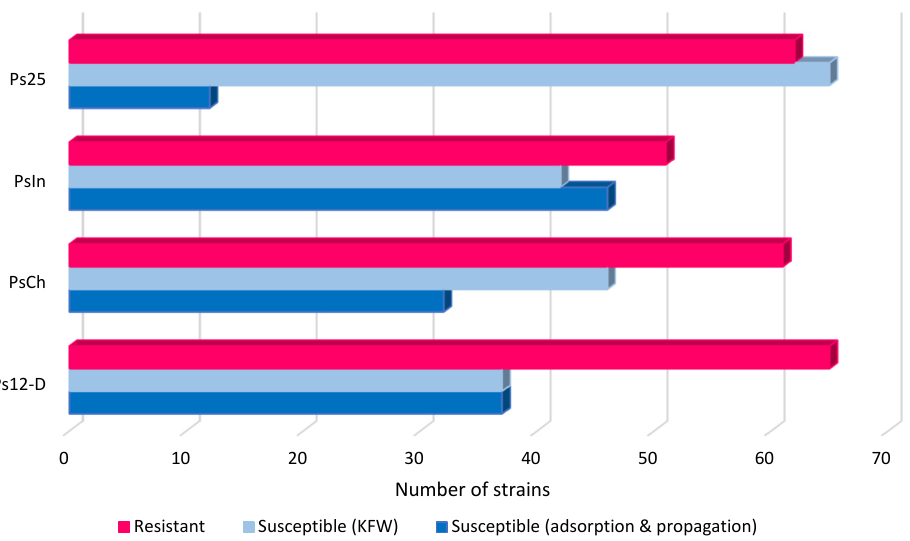
Figure 3. Host range chart of the phages PsIn, PsCh, Ps12on-D, and Ps25, as determined on 140 P. aeruginosa isolates. Resistant: (-) no lysis; susceptible: (KFW) killing from without; susceptible: adsorption and propagation confluent lysis, semi-confluent lysis, opaque lysis, and separate plaque in high and low dilutions.